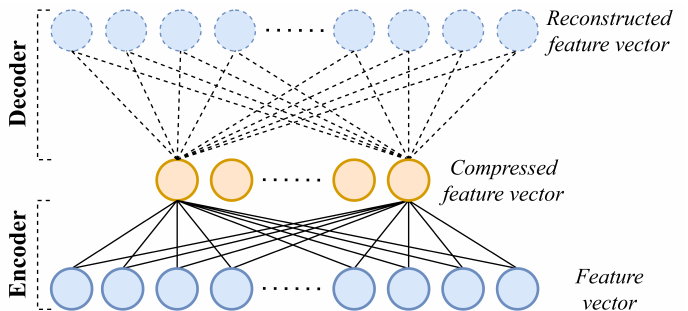
Figure 1. Illustration of a vanilla 1-layer AE. The input and output layers have the same number of neurons while the hidden layer is smaller to serve the idea of mapping original data from a high dimension space into a lower